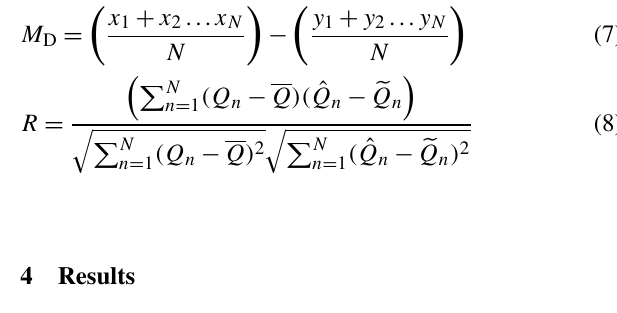
Figure 6. Streamflow calibration (2000–2005) and validation